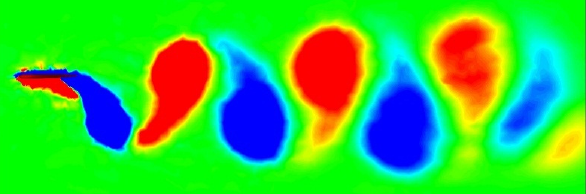
Figure 9. Two-dimensional vorticity contours in the wake.